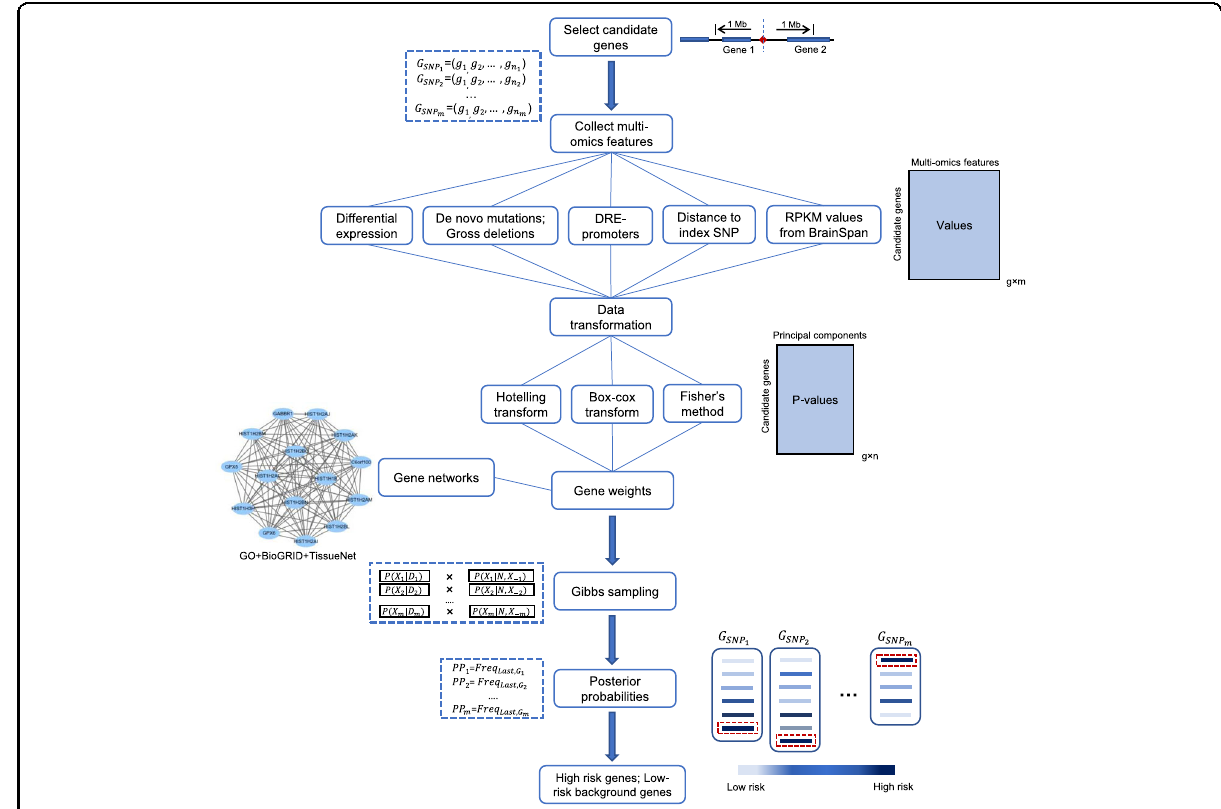
Fig. 1 Schematic of the rGAT-omics framework. Candidate genes were initially de fi ned as genes located within 1 Mb of SNPs associated with SCZ. The multi-omics data characterizing each gene were integrated by means of the Hotelling transform, the Box – Cox transformation, and Fisher ’ s method (Fisher ’ s combined probability test). The candidate genes were mapped to GO and PPI networks. The conditional probability of each candidate gene being a risk gene was then calculated based on the integrated multi-omics features and moving probability of selected genes in the GO and PPI networks obtained by a random walk with restart (RWR). One candidate gene with known conditional probability was sampled by Gibbs sampling to calculate the selecting frequency Freq i ; the sampling was then continued until the frequency difference Freq i þ 1 (cid:2) Freq i than E Gibbs ¼ 0 : 01, which yielded the posterior probability (PP) for each candidate gene. For each locus, the candidate gene with the highest PP was considered to be the high-risk gene (HRG), whereas the candidate genes with PP values lower than the median value for all candidate genes were de fi ned as low-risk background genes (LBGs). D l denotes the multi-omics features of gene l ; N denotes GO and PPI